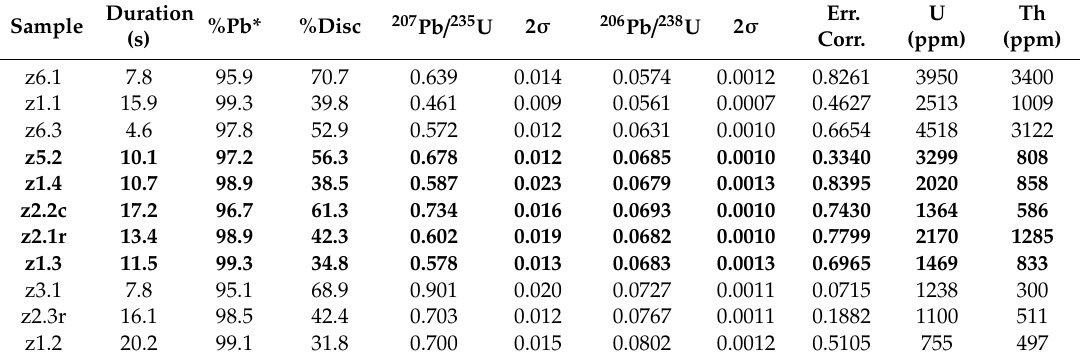
Figure 12. U-Pb concordia diagram for four analyses of the Temora 1 zircon standard. Data point error ellipses are reported at 2 σ . Table 1. U-Pb zircon geochronological data from Lake George Granodiorite (sample LG-80-33-2017). Pb* represents the percentage of radiogenic lead present in the